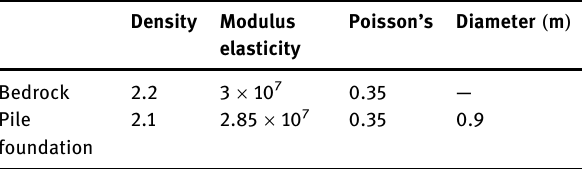
Table 1: Material parameters of bedrock and pile